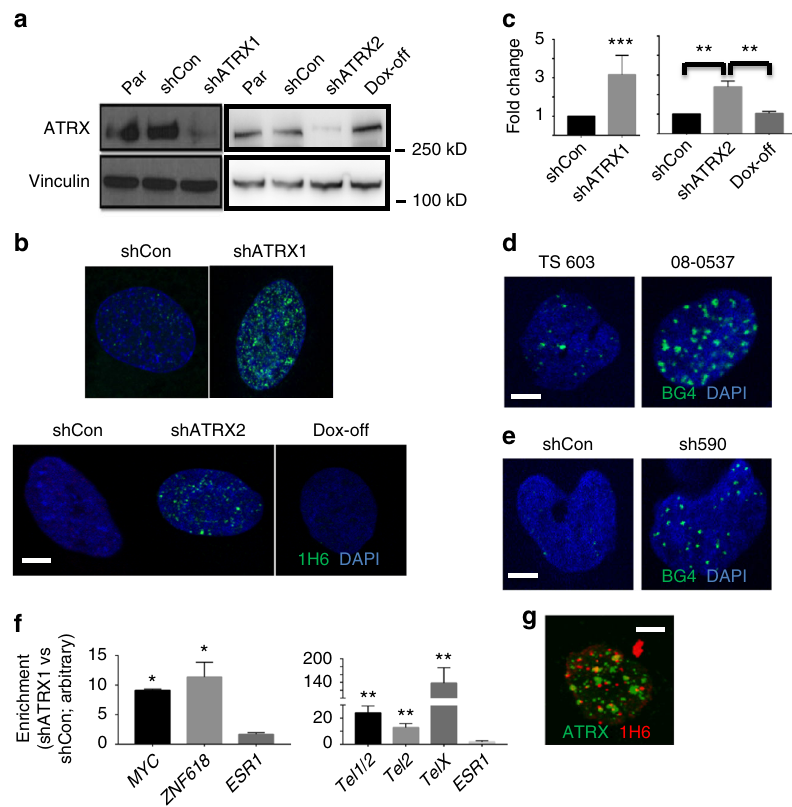
Fig. 1 ATRX de fi ciency promotes G4 formation. a Western blots for ATRX in parental (Par), shControl (shCon), and shATRX NHA (Vinculin loading control). Left panel shows constitutive NHA lines (shATRX1) and right panel shows the inducible lines post Doxycycline induction (shATRX2) and withdrawal (Dox-off). b Immuno fl uorescent staining of G4 (1H6) in constitutive (upper panel) and inducible (lower panel) NHA lines (DAPI counterstain). c Quanti fi ed relative G4 signal intensity (50 nuclei counted in all cases). d , e Immuno fl uorescent staining of G4 (BG4) in ATRX -intact (TS 603) and ATRX - mutant (08-0537) GSCs ( d ) and in TS 543 GSCs ( e ) subjected to ATRX knockdown (sh590) versus control (shCon; DAPI counterstain). f G4-containing DNA fragments from shCon and shATRX1 NHAs (three replicates each) were pulled down from sheared genomic DNA with puri fi ed hf2 antibodies. Recovered DNA was subjected to real-time PCR for telomeric sequences or G4-rich promoter regions of MYC and ZNF618 ( ESR1 used as negative control). Graphs show enrichment over GAPDH scaled to shCon levels. g ATRX and G4 immuno fl uorescence in parental NHAs showing no signi fi cant colocalization. Where applicable, error bars re fl ect SEM; P values determined by unpaired, two-tailed t -test (* P < 0.05, ** P < 0.01, *** P < 0.001); scale bars represent 10 µ